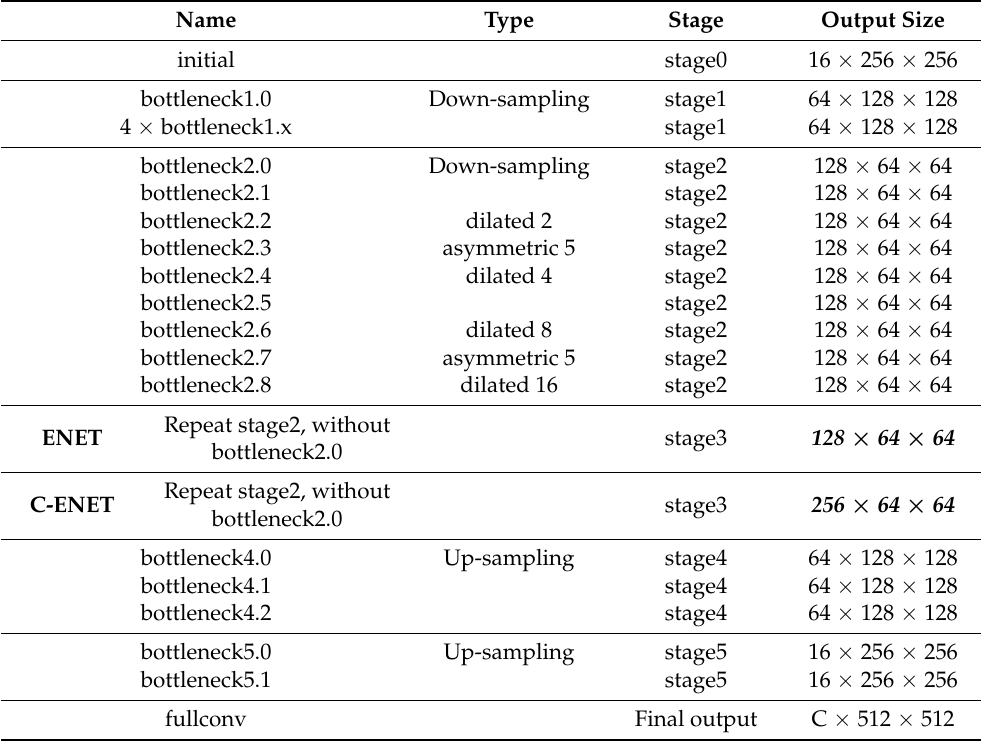
Table 1. In stage 3, the output of 128 × 64 × 64 was replaced by an output of 256 × 64 × 64. This implies a DSC distribution on average greater and with less variability than ENET, as shown in Section 3. Table 1. Difference between ENET and C-ENET network